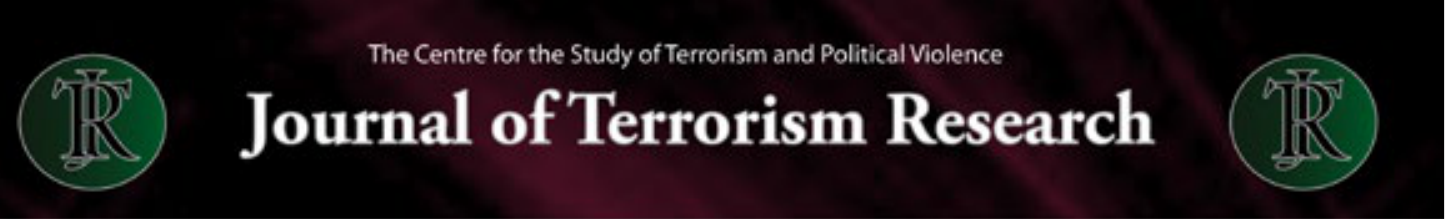
Table 5. The Proportion of Tweets Expressing Positive and Negative Sentiment for Tweets Mentioning Each of The 14 Concepts (P(Concept |Concept Sentiment c